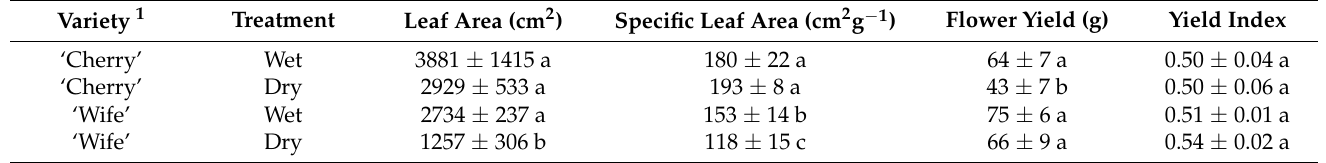
Table 1. Morphological and biomass responses to induced water stress for two varieties of industrial hemp, Wife and Cherry, including leaf density expressed as total leaf area per plant, total flower yield, and yield index defined as the ratio of flower weight to total